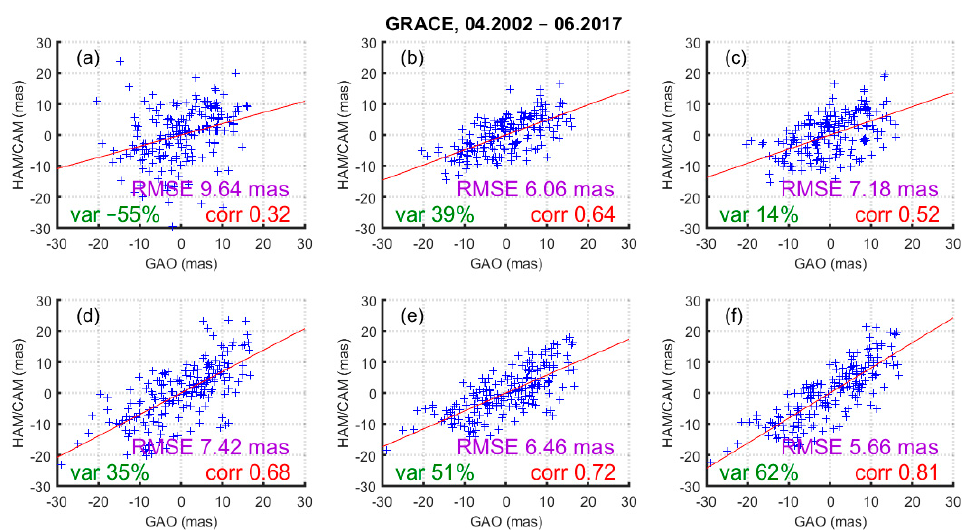
21 of 28 are considered. All GRACE- and GRACE-FO-based HAM/CAM series were computed using data from JPL. Table 3. Standard deviation (STD) of GAO and HAM/CAM (from GSM, TWS, and MAS) series and trends in GAO and HAM/CAM (from GSM, TWS, and MAS) series. All GRACE- and GRACE-FO- based HAM/CAM series were computed using data from JPL. Trend errors are given in brackets. Time